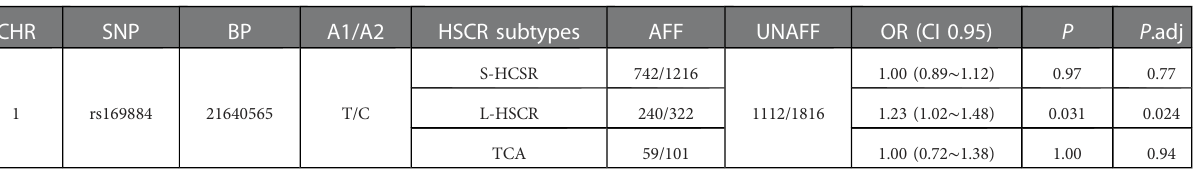
TABLE 3 Association between SNP rs169844 and different subtypes of